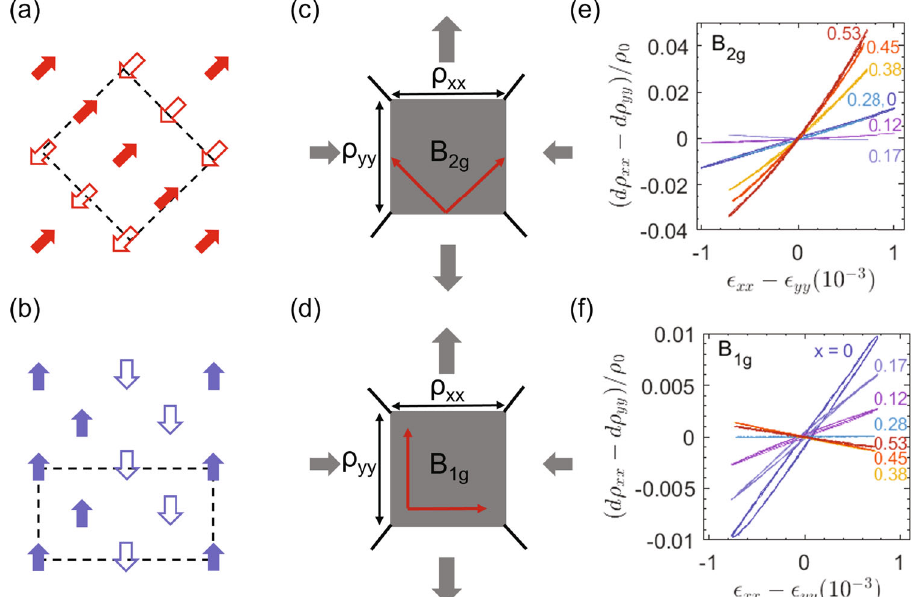
Fig. 1 Spin con fi gurations and elastoresistivity con fi gurations. a , b Schematic spin con fi gurations of the ( a ) single-stripe phase, with Q = ( π , π ), and ( b ) double-stripe phase, with wave-vector Q = ( π , 0). c , d Schematic diagrams of the Montgomery method for the elastoresistivity measurement in c B 2 g and d B 1 g con fi guration. e , f The anisotropic resistivity ( ρ xx − ρ yy ) as a function of anisotropic strain ( ϵ xx − ϵ yy ) for annealed Fe 1 + y Te 1 − x Se x (0 ≤ x ≤ 0.53) at T = 20 K in e B 2 g and f B 1 g channels. The B 1 g elastoresistivity coef fi cient m 11 − m 12 and B 2 g elastoresistivity coef fi cient 2 m 66 can be obtained by fi tting the linear slope of resistivity versus strain. The samples with high doping concentrations ( x = 0.38, 0.45, 0.53) show predominantly a B 2 g response while the low doping ones ( x = 0, 0.12) show comparable B 1 g and B 2 g